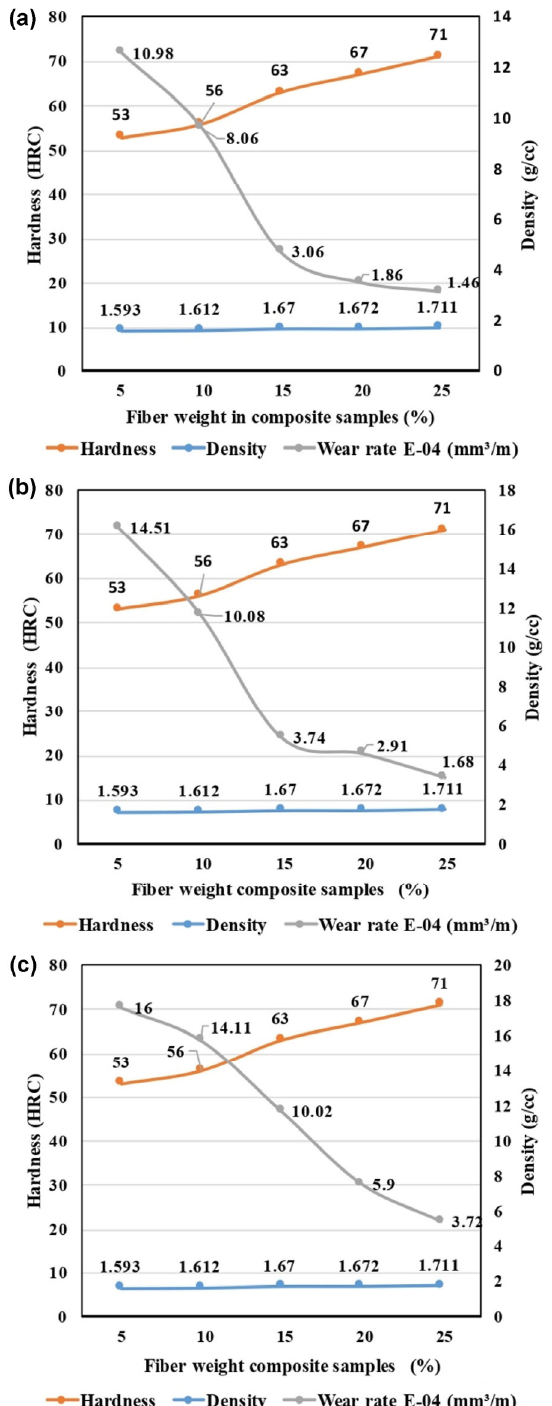
Fig. 17 Plot wise presentation of wear rate, hardness, density, and fiber weight relationship at (a) 5 N, (b) 10 N, and (c) 20